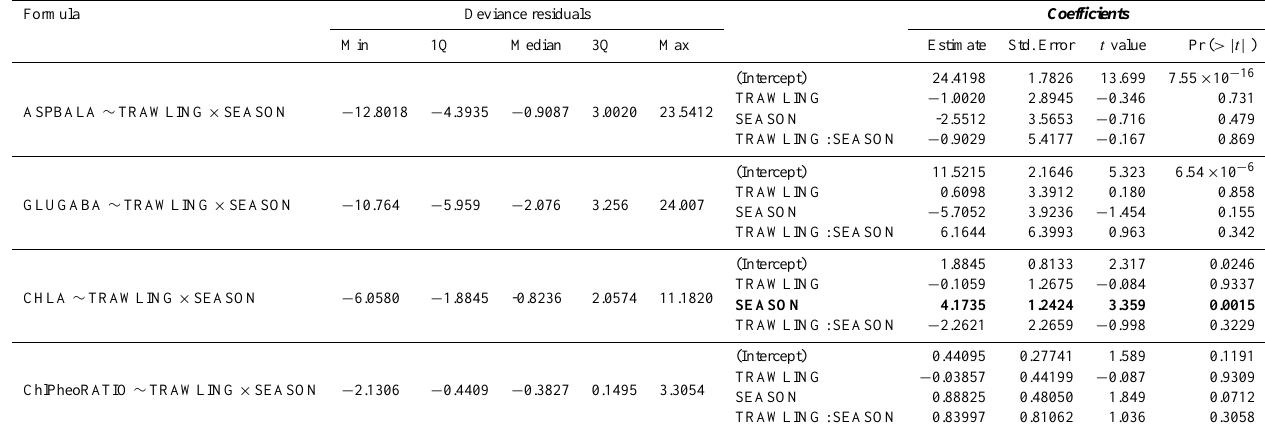
Table 2e. Results of the generalized linear model (GLM) for pigments (Chl a and Chl a -to-Pheo a ratio) and amino acids (Asp-to-BALA and Glu-to-GABA ratios). Formula Deviance